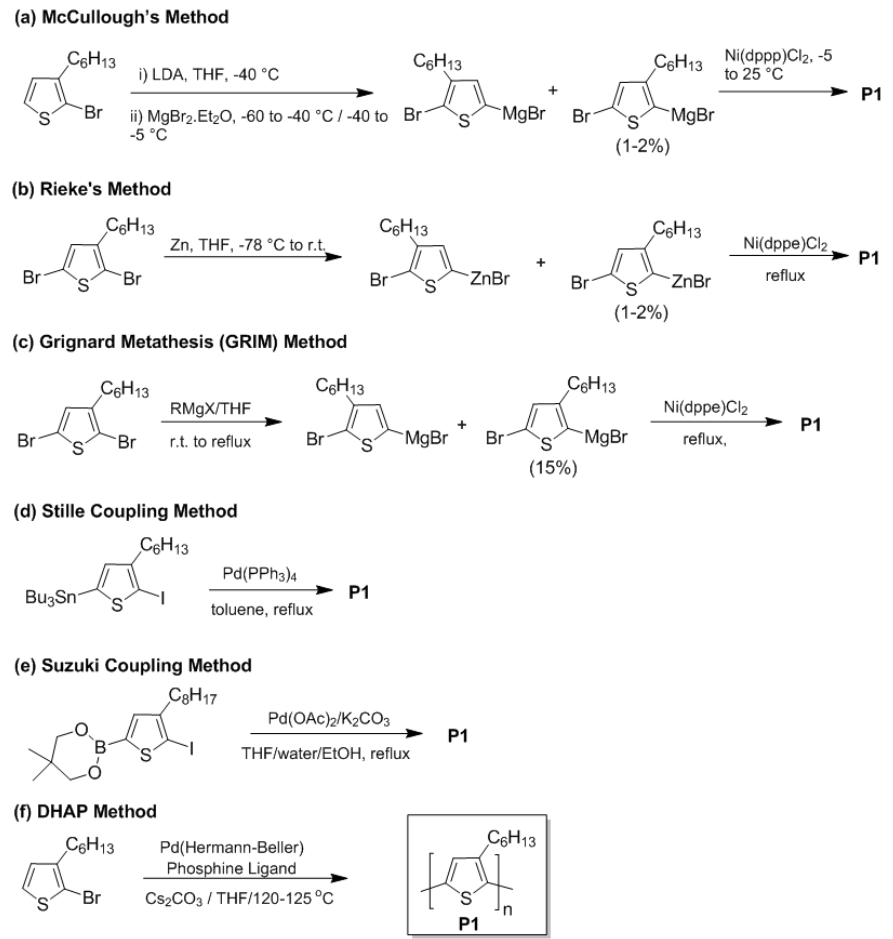
Figure 2. Synthesis of rr-P3HT by ( a ) McCullough’s [38], ( b ) Rieke’s [40], ( c ) Grignard metathesis (GRIM) [43], ( d ) Stille coupling [42], ( e ) Suzuki coupling [41], and ( f ) DHAP [45]